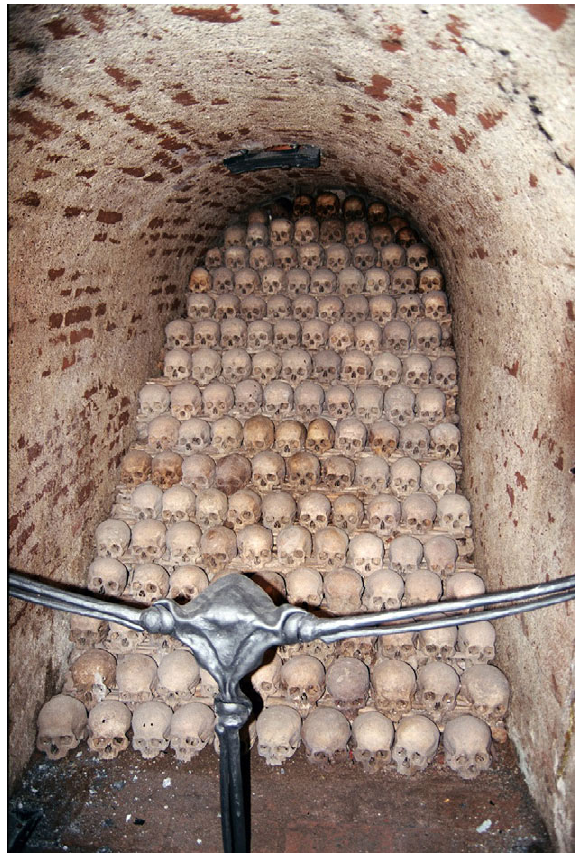
Fig. 7. The Ossuary under the Saint James Church – an example of underground funeral anthropogenic landform (Photo: K. Kirchner,